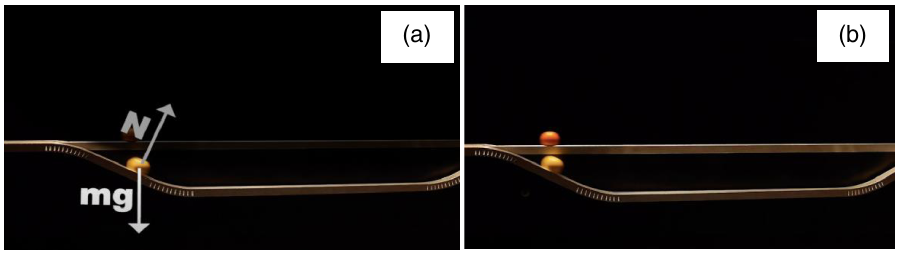
FIG. 6. Screenshot from the high road, low road demo video versions which (a) had enhanced visuals (versions 1 and 3) and (b) did not have enhanced visuals (versions 2 and